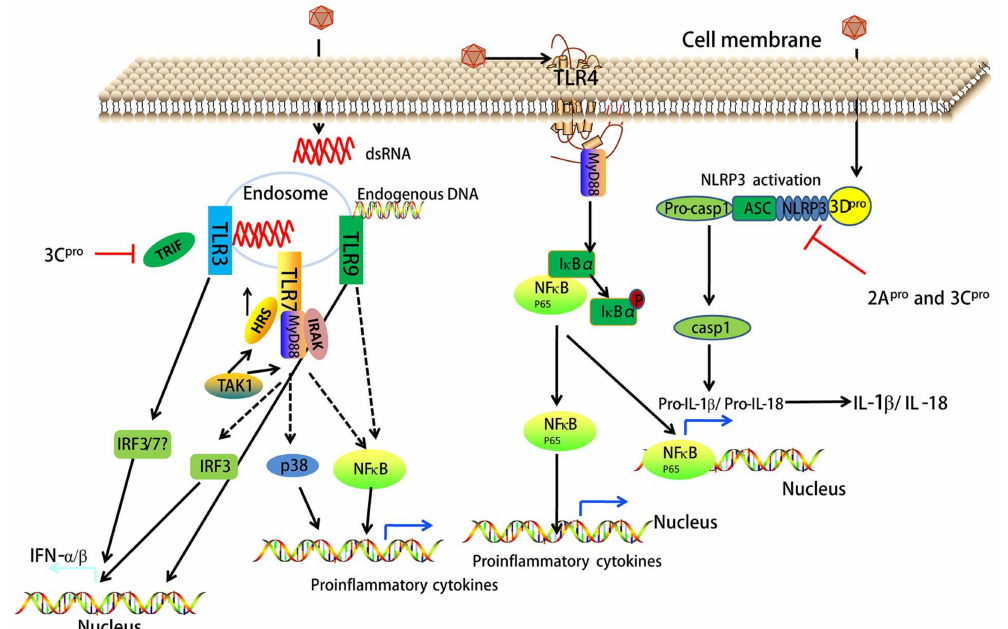
Figure 4. EV71 directly influences antiviral innate immunity and inflammatory responses by targeting pattern recognition receptors (PRRs). TLRs and NOD-like receptors (NLRs) belong to PRRs that sense lipids, lipoproteins, or peptidoglycans from bacteria, fungi, or protozoa, namely pathogen-associated molecular patterns (PAMPs). Additionally, these PRRs sense bacterial and viral nucleic acids, termed damage-associated molecular patterns (DAMPs). Endosomal TLR3 and TLR7 sense dsRNA of EV71. 3C pro inhibits TLR3-mediated type I IFN production by blocking Toll/IL-1 Receptor domain-containing adaptor inducing IFN- β (TRIF). The interaction between hepatocyte growth factor-regulated tyrosine kinase substrate (HRS) and TAK1 regulates the ESCRT-0 complex and endosomal sorting of membrane proteins. HRS facilitates TLR7/NF- κ B/p38 and TLR7/NF- κ B/IRF3 signaling to produce proinflammatory cytokines and interferons during EV71 infection. Unlike TLR3 and TLR7, TLR9 senses endogenous DNA, and then mediates type I IFN production and NF- κ B activation. EV71 infection also activates TLR4/myeloid differentiation primary response 88 (MyD88)-dependent NF- κ B signaling, which induces multiple proinflammatory cytokines including pro-IL-1 β and pro-IL-18. 3D pro controls the assembly of the NLRP3 inflammasome that consists of pro-caspase-1 (casp1), ASC, and NLR family pyrin domain containing protein-3 (NLRP3). When activated, pro-casp1 matures into casp1 that cleaves pro-IL-1 β and pro-IL-18 to become the mature IL-1 β and IL-18 proteins. 2A pro and 3C pro can inhibit NLRP3 inflammasome activation. 9. EV71-Associated NOD-Like Receptor (NLR)